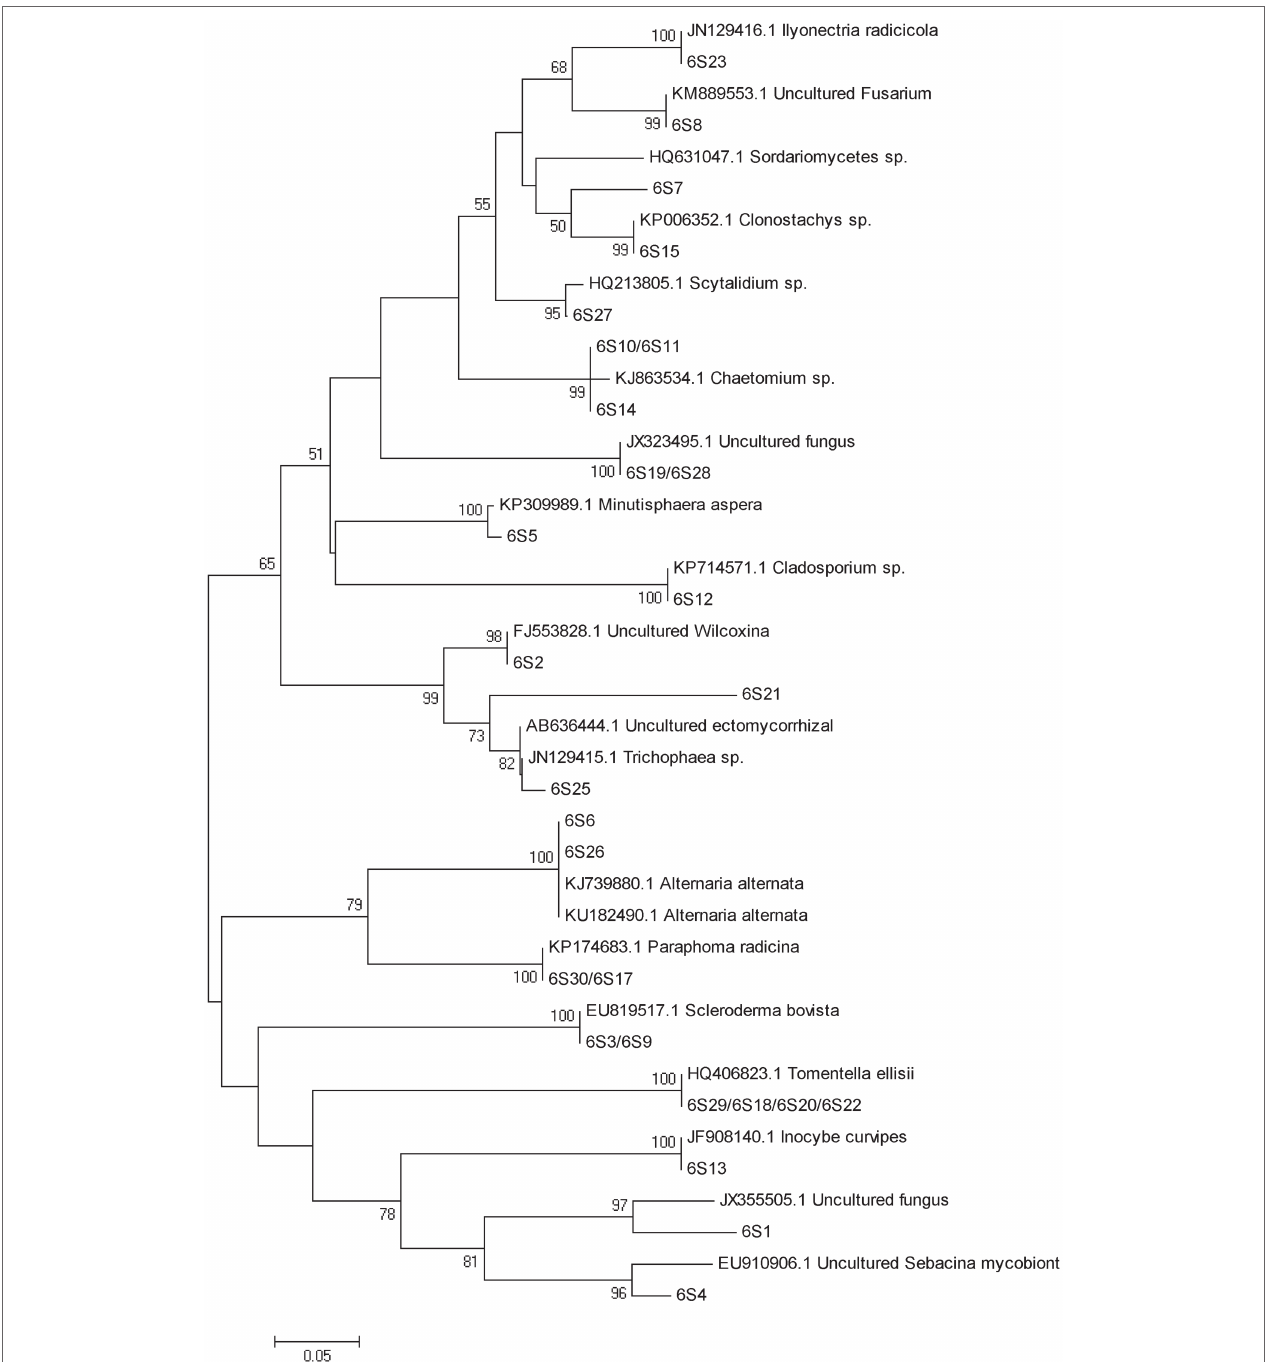
FIGURE 7 | Neighbor-joining phylogenetic tree of fungi at 6 months after PWN